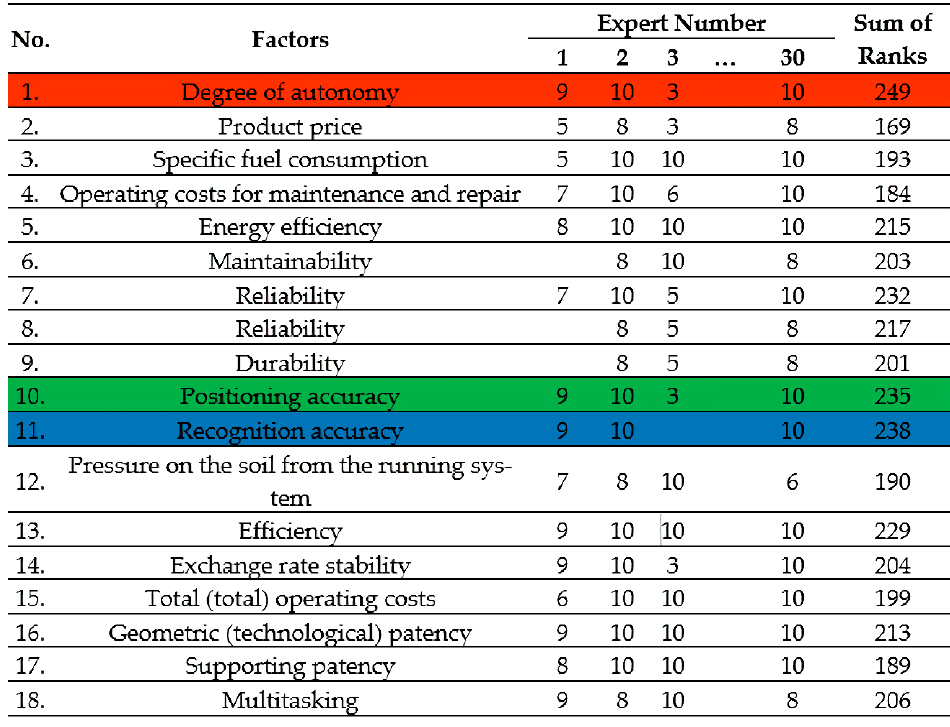
Figure 11. Selected factors and their ranking results.